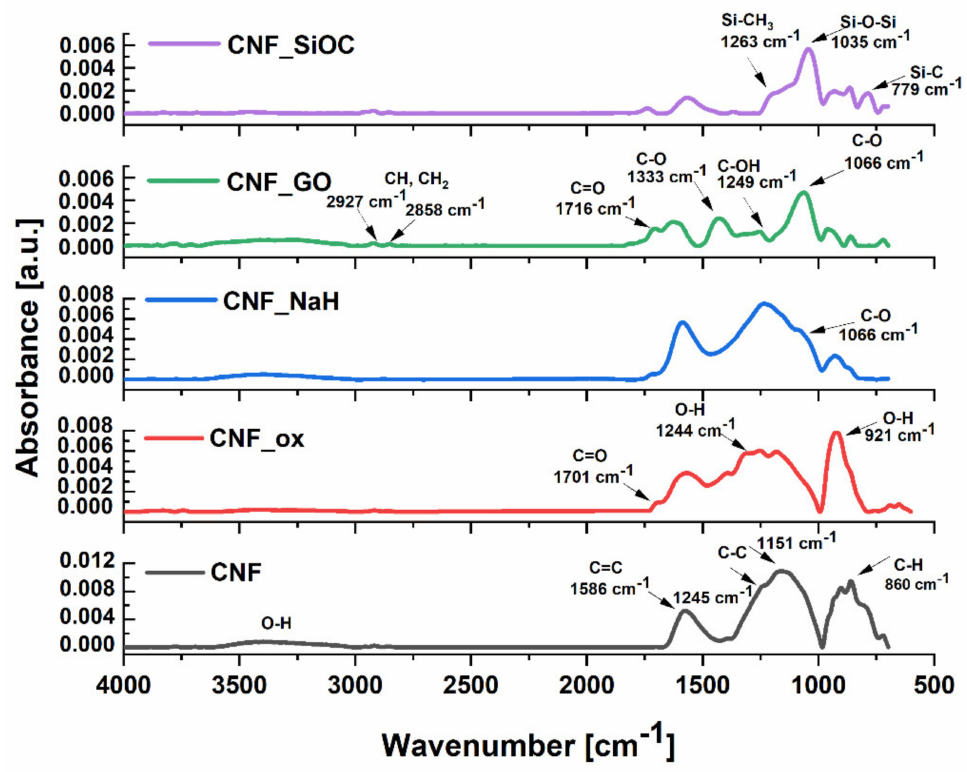
Figure 5. FT-IR spectra of the CNF before and after